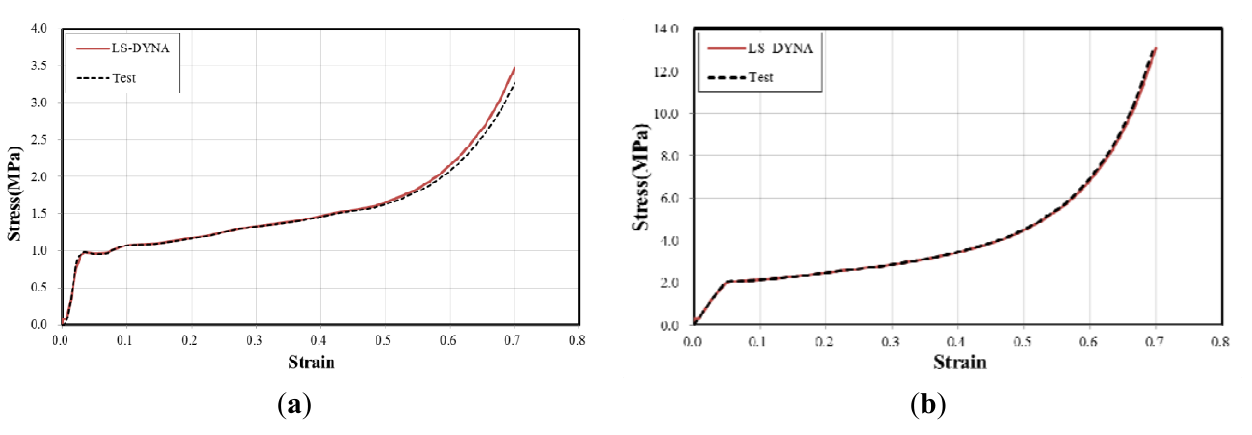
Figure 4. Verification of material models: ( a ) Foam density 200 kg/m 3 ; ( b ) Foam density 370 kg/m 3